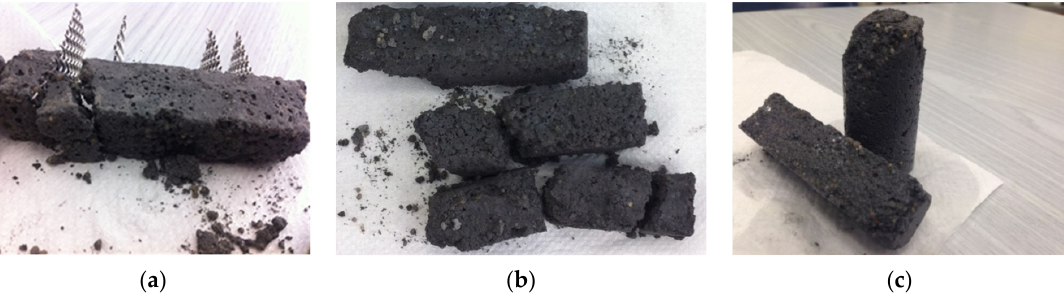
Figure 6. White cement mortar specimens with the Triton X ‐ 100 superplasticizer that were partially fractured during demolding: ( a ) electrical resistivity, ( b ) flexure, and ( c ) compression specimens.